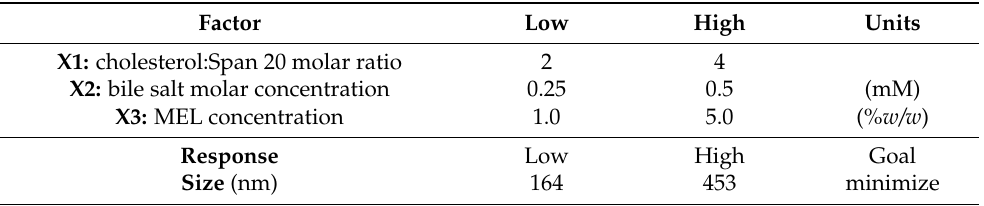
Table 3. Factors involved in Box-Behnken design and their selected levels with the response and their constraints and goals.